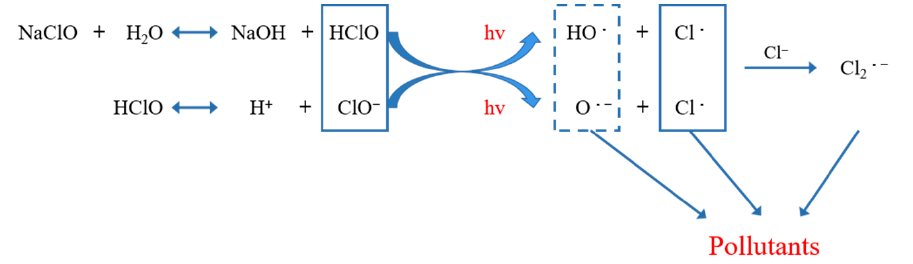
Figure 4. Process diagram of UV photolysis of sodium hypochlorite.